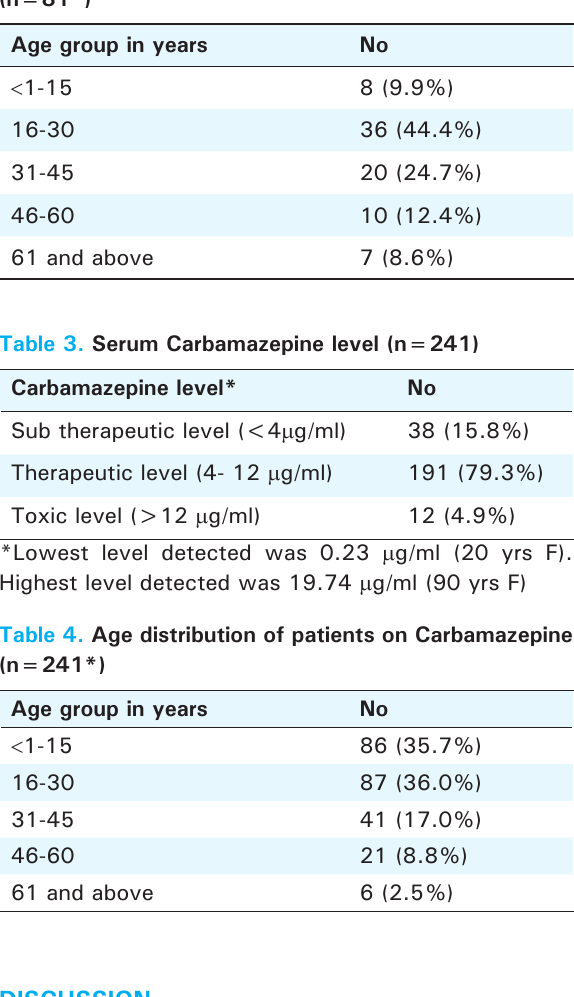
Table 2. Age distribution of patient taking Phenytoin